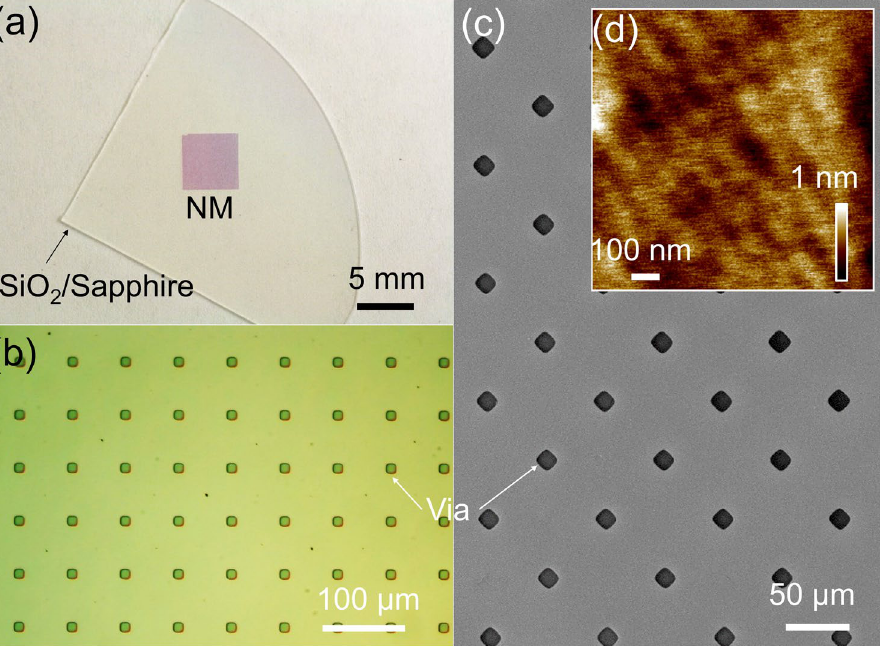
Figure 2. ( a ) An AlGaN/GaN/AlGaN NM on SiO 2 /Sapphire, ( b ) Microscopy image of a NM on SiO 2 /Si with diagonal spacing of 100 µ m, ( c ) and ( d ) SEM and AFM images of the Ga-polar surface of a NM,